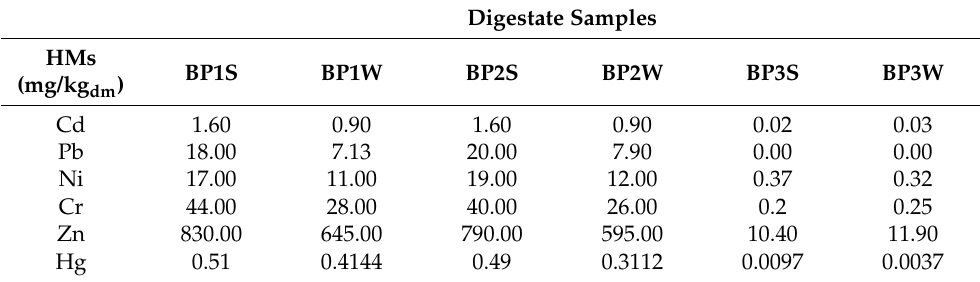
Table 2. Content of heavy metals (HMs) in digestate